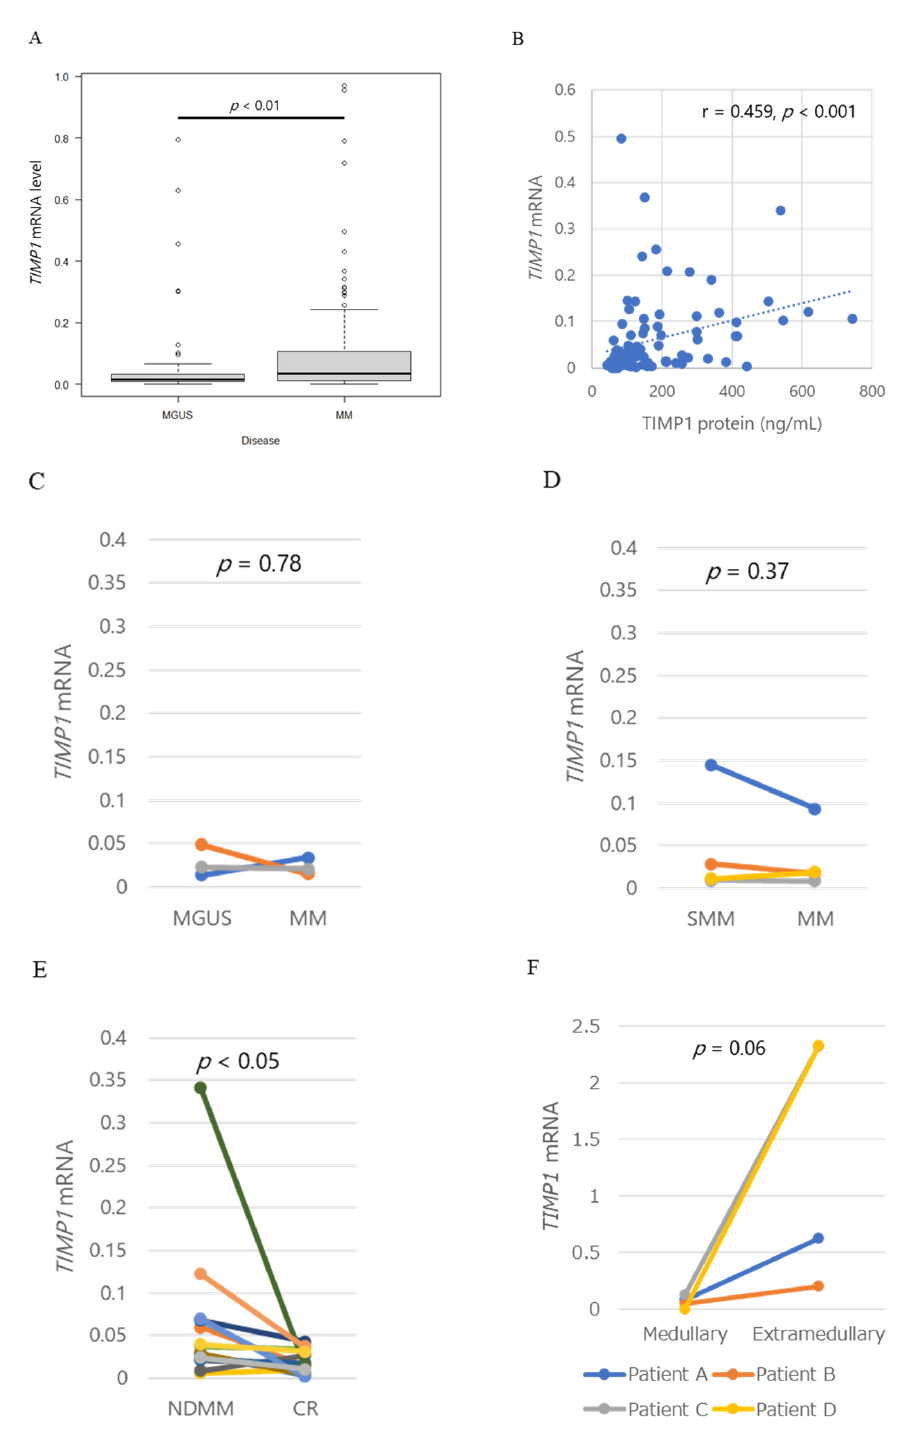
Figure 2. TIMP1 mRNA levels and TIMP1 protein levels. ( A ) Box plot of TIMP1 mRNA levels in controls and patients with MGUS or MM. ( B ) Correlation between TIMP1 concentrations in bone marrow plasma and TIMP1 mRNA levels in bone marrow myeloma cells in patients. Each dot represents an individual patient. TIMP1 mRNA levels in myeloma cells in bone marrow plasma from patients with ( C ) MGUS and MM, ( D ) SMM and MM, and ( E ) MM at newly diagnosis and at CR. ( F ) TIMP1 mRNA levels in intramedullary myeloma cells and extramedullary myeloma cells. Pairwise comparisons were performed in corresponding patients. Different colors of lines indicate corresponding patients.